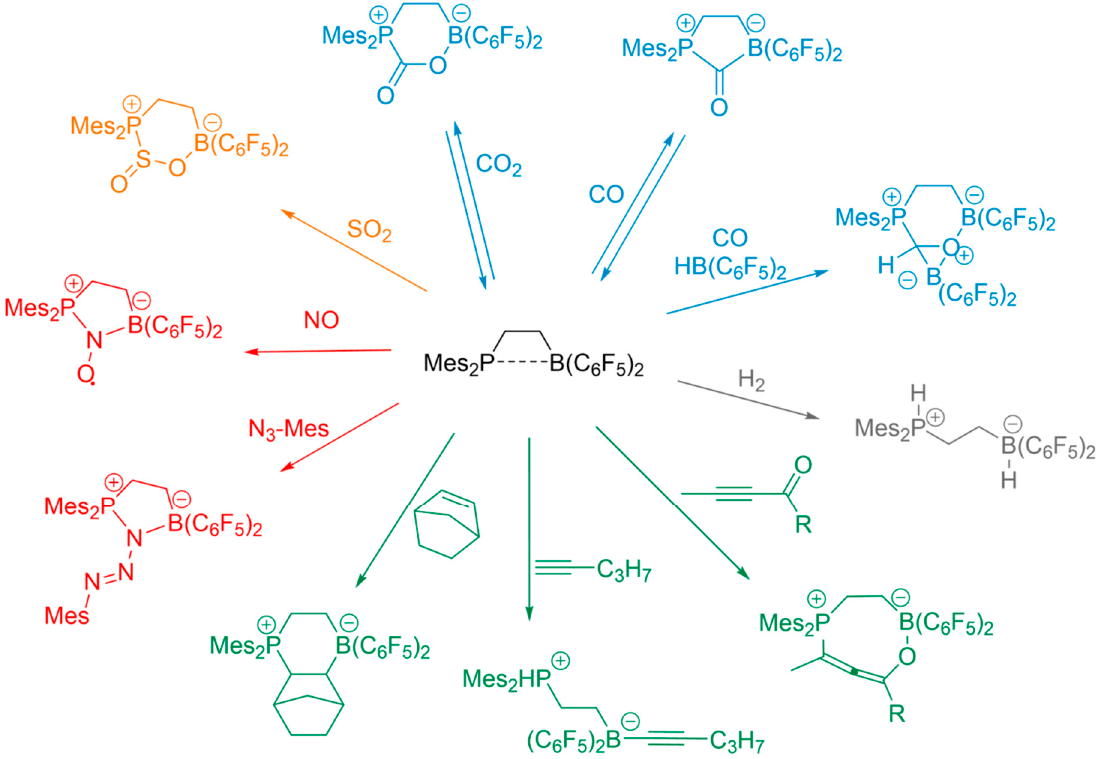
Figure 1. Schematic overview for various chemical reactions performed with intramolecular borane– phosphane (B/P) frustrated Lewis pairs